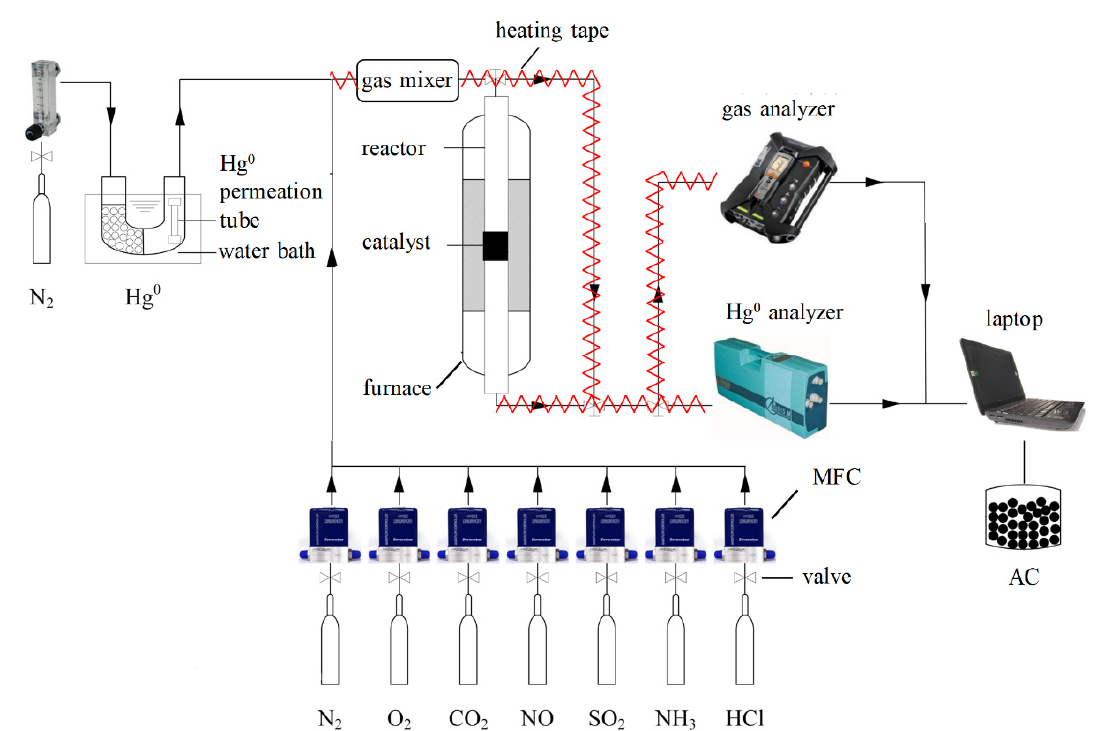
Figure 2. Schematic of the elemental mercury removal system.